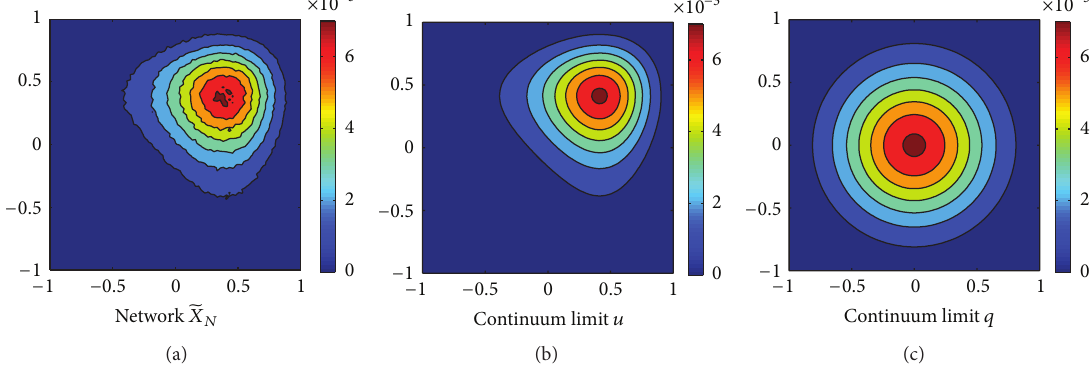
Figure 7: A nonuniform network, its limiting PDE solution, and the limiting PDE solution of its mirroring uniform